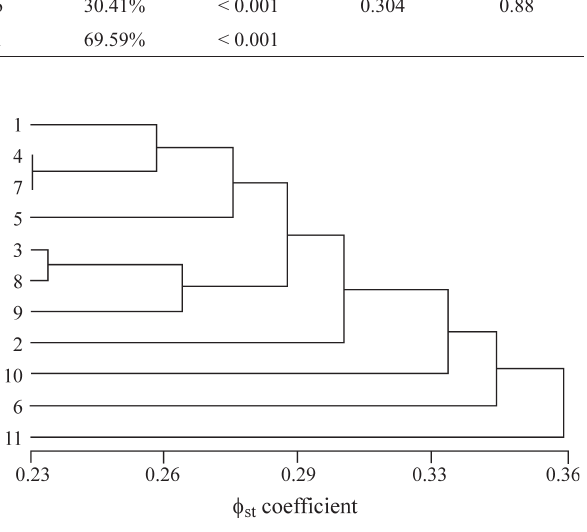
Figure 3 - Unweighted pair group method with averages (UPGMA) dendrogram showing the genetic distance between eleven Eupemphix nattereri populations based on genetic divergence ( Φ st